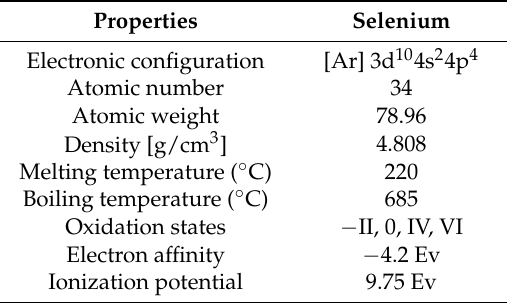
Table 1. Selected physical and chemical properties of